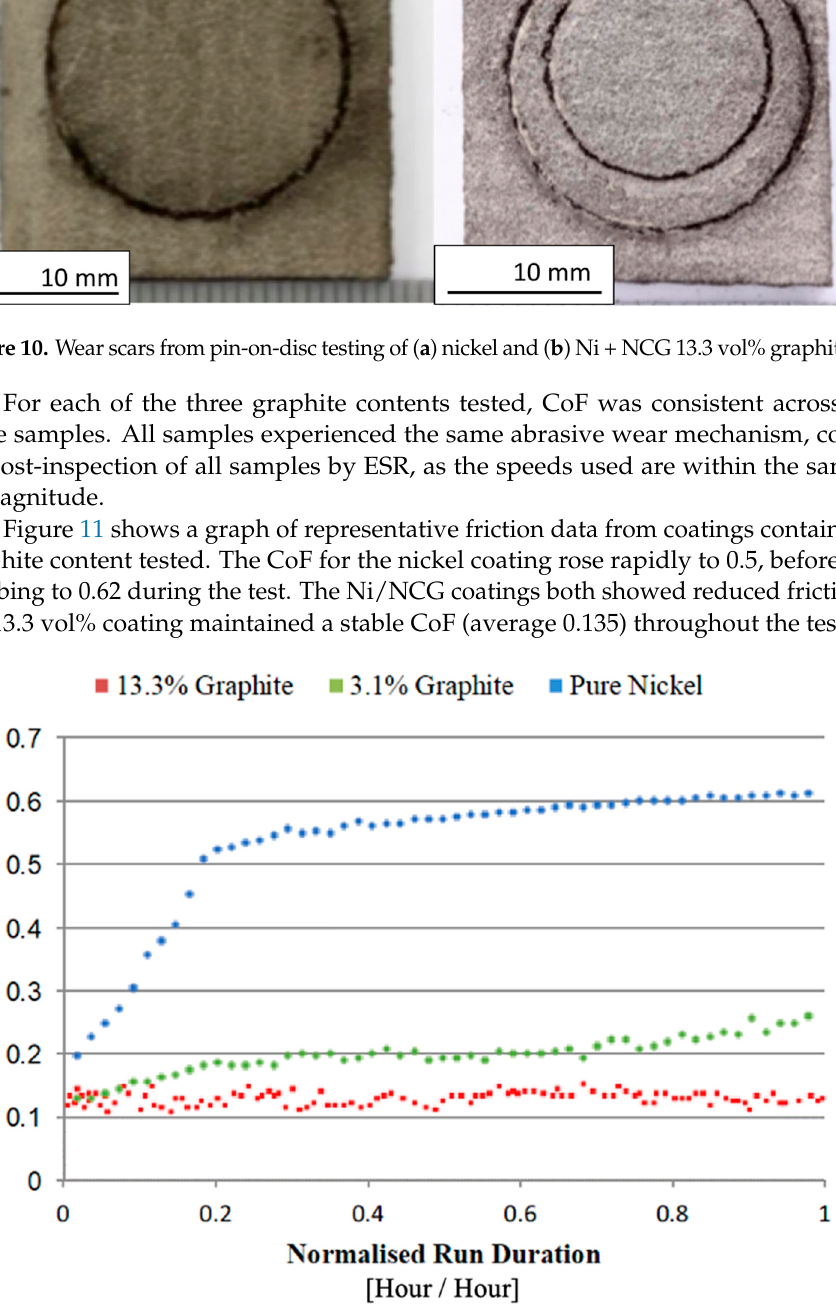
( c ) Figure 9. Micrographs showing ( a ) NCG particles co-deposited with nickel powder, ( b ) NCG alone, and ( c ) raw NCG powder before spraying for comparison. Although pure NCG feedstock with an initial graphite fraction of 41% could be de- posited as single tracks, it did not prove to be suitable for coating deposition. When at- tempting to deposit a coating from partially overlapping single tracks, each new track eroded the previously deposited track adjacent to it, so that no coating was formed. Coat- ing deposition was only successful with Ni + NCG feedstock mixtures with graphite vol- ume fractions of up to 30 vol%. Tracks deposited onto aluminium retained a higher graphite fraction than those de- posited onto titanium, reaching a maximum of 17.4 vol%. Given this finding, coatings of three different compositions were deposited onto aluminium for pin-on-disc testing. The same deposition conditions were used for each coating composition: traverse rate of 40 mms − 1 , track overlap of 50%, and laser power 1500 W. The graphite content and porosity of the coatings produced are detailed in Table 4. Table 4. Graphite content and porosity in the coatings prepared for wear testing.